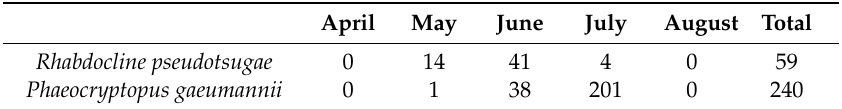
Table 2. Timing and intensity (number of spores) of needle cast sporulation obtained from the Burkard automated spore trap on H ˚ u rky trial in